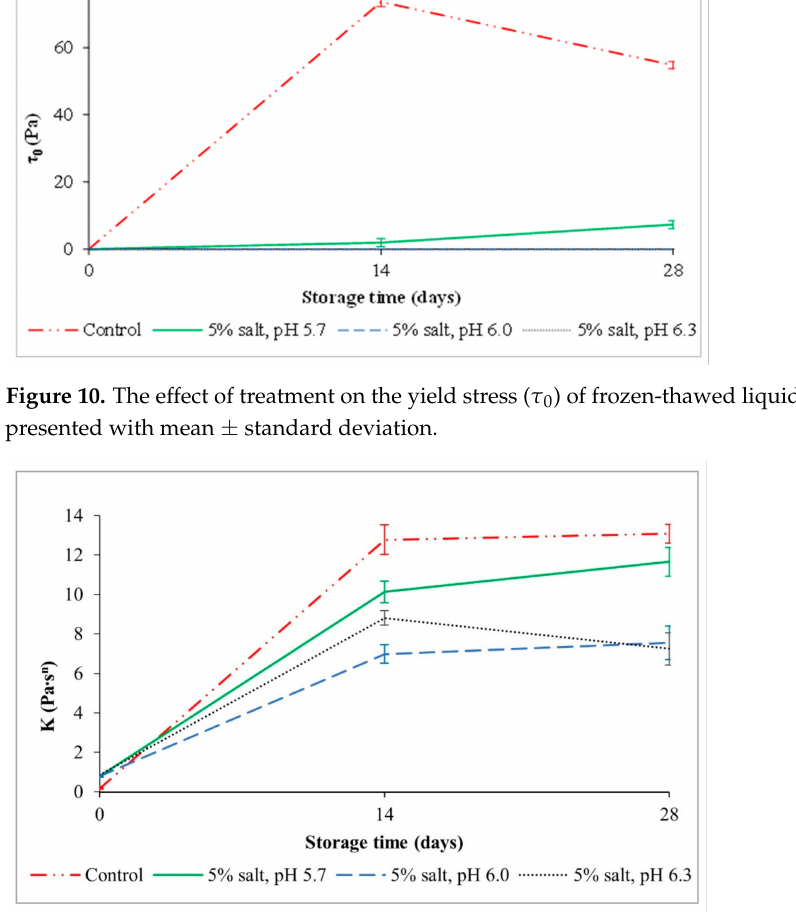
Figure 11. The effect of treatment on the consistency coefficient (K) of frozen-thawed liquid egg yolk. Data are presented with mean ± standard deviation.